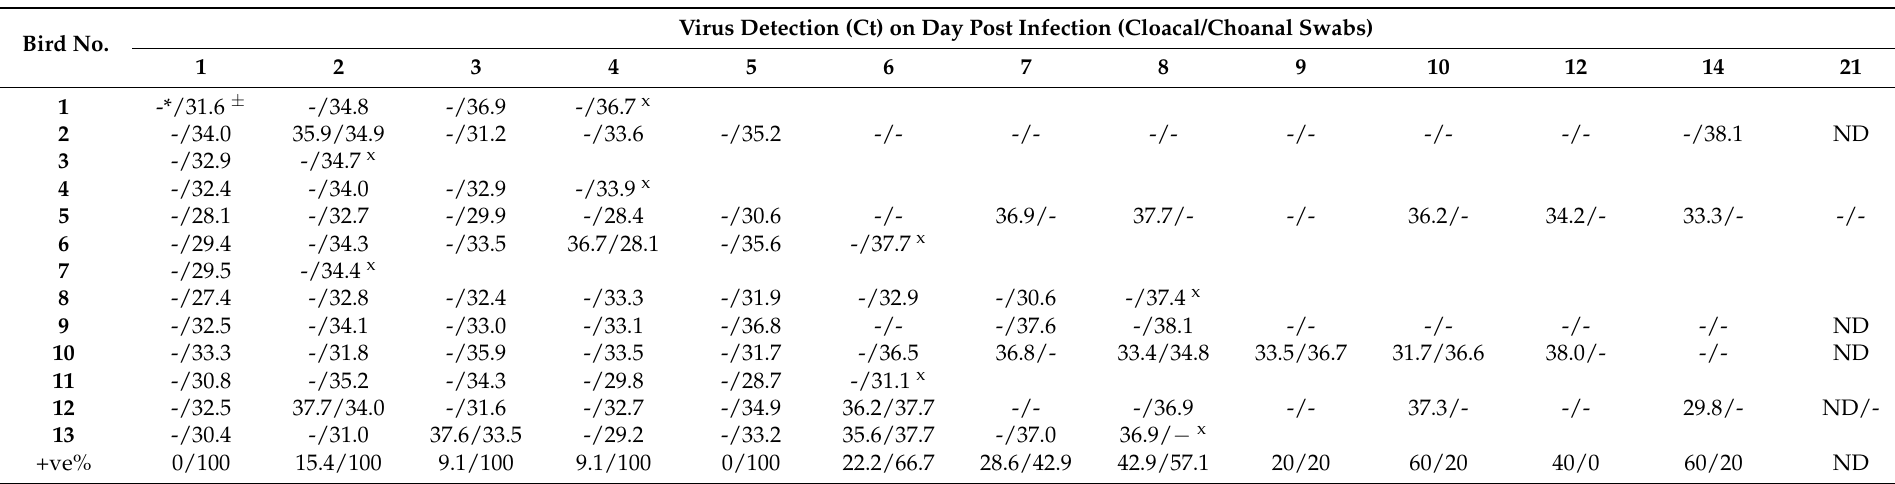
Table 5. Virus detection by real-time RT-PCR testing of cloacal and choanal swabs collected from SPF chickens experimentally infected with P/Aus/3/11 isolate. Bird